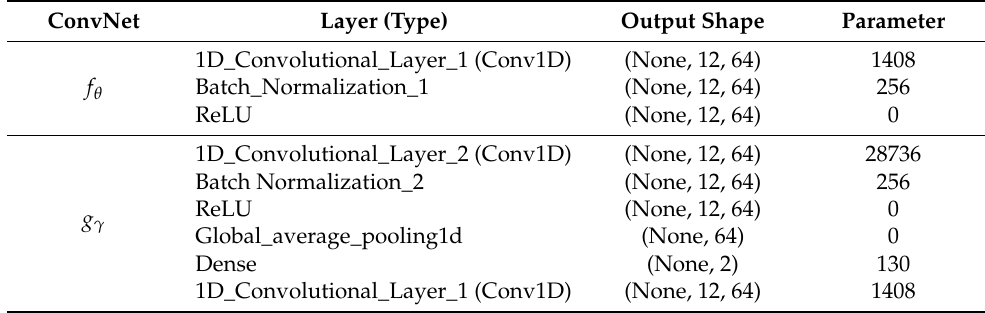
Table 2. Classification model in our dataset for identifying time-series data